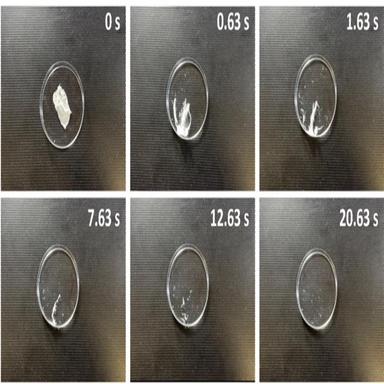
Disintegration process of PEO-IBP composites at various time intervals throughout the disintegration study.